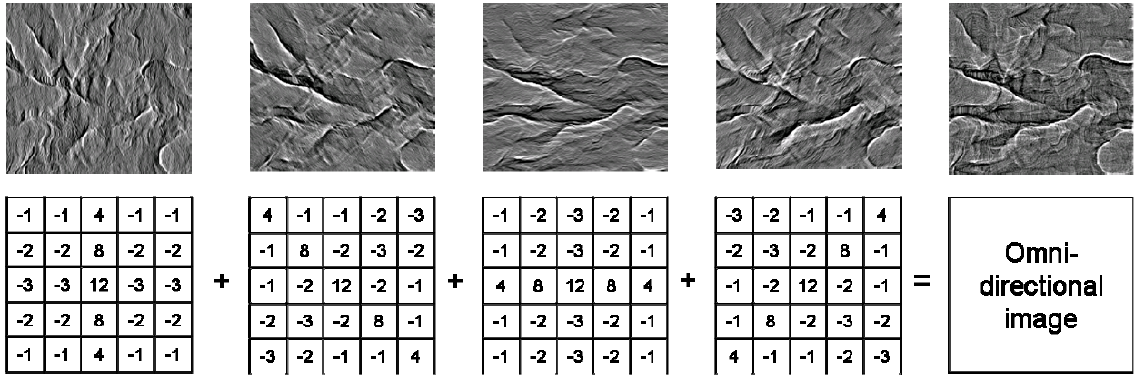
Figure 2. Applied 5x5 2nd order Laplacian linear filter on 30x30 median filtered ASTER GDEM and the result after combining all directional images to one omni-directional image keeping the maximum value of each pixel.